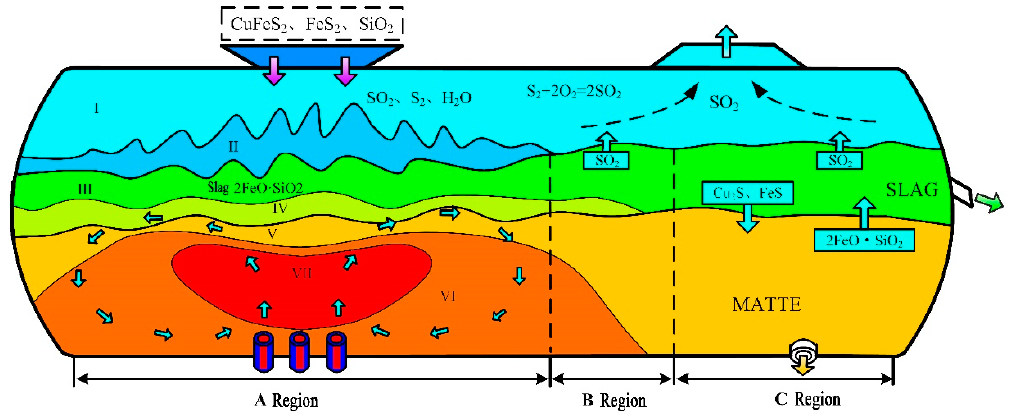
Figure 3. SKS mechanism model-II.